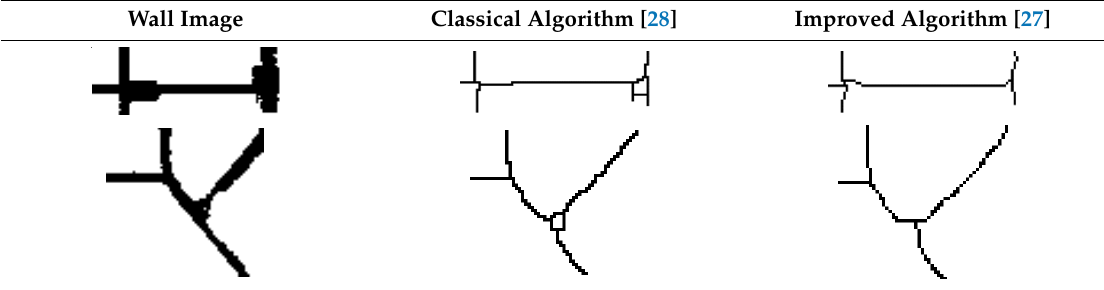
Table 6. Centerline detection results with two algorithms.